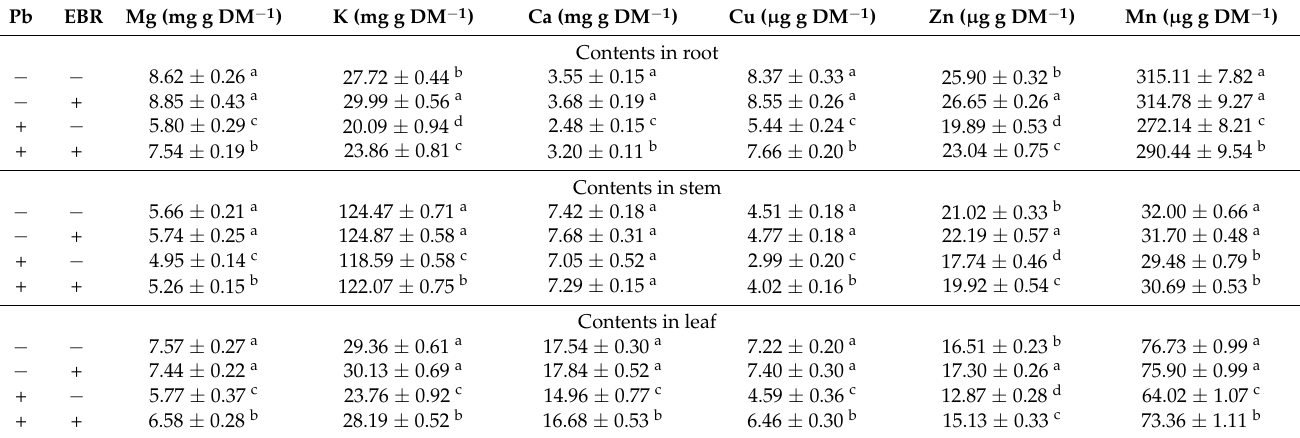
Table 3. Nutrient contents in tomato plants treated with EBR and subjected to Pb toxicity.